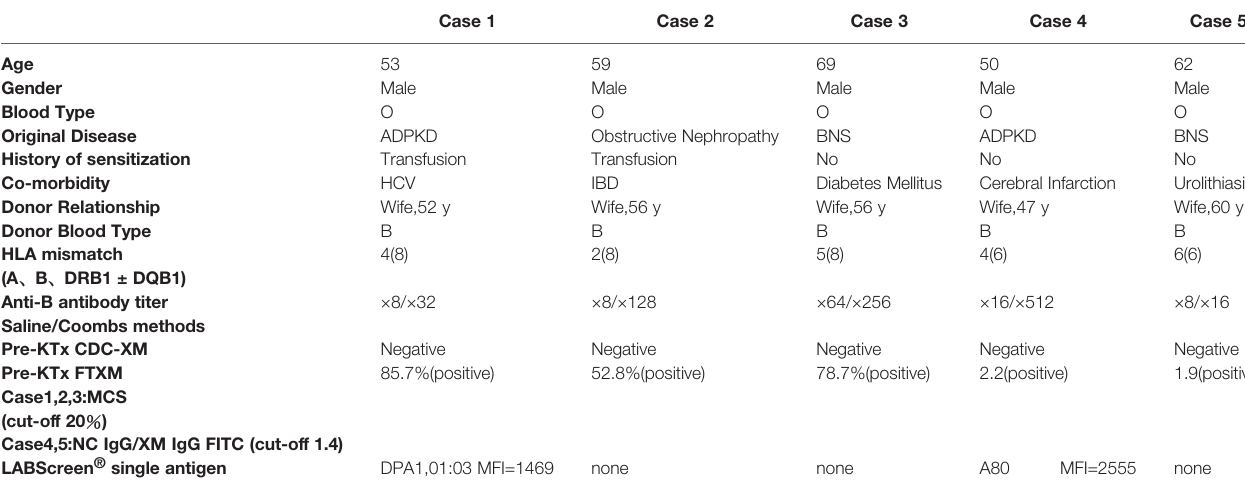
TABLE 2 | Demographic and clinical features of FTXM positive